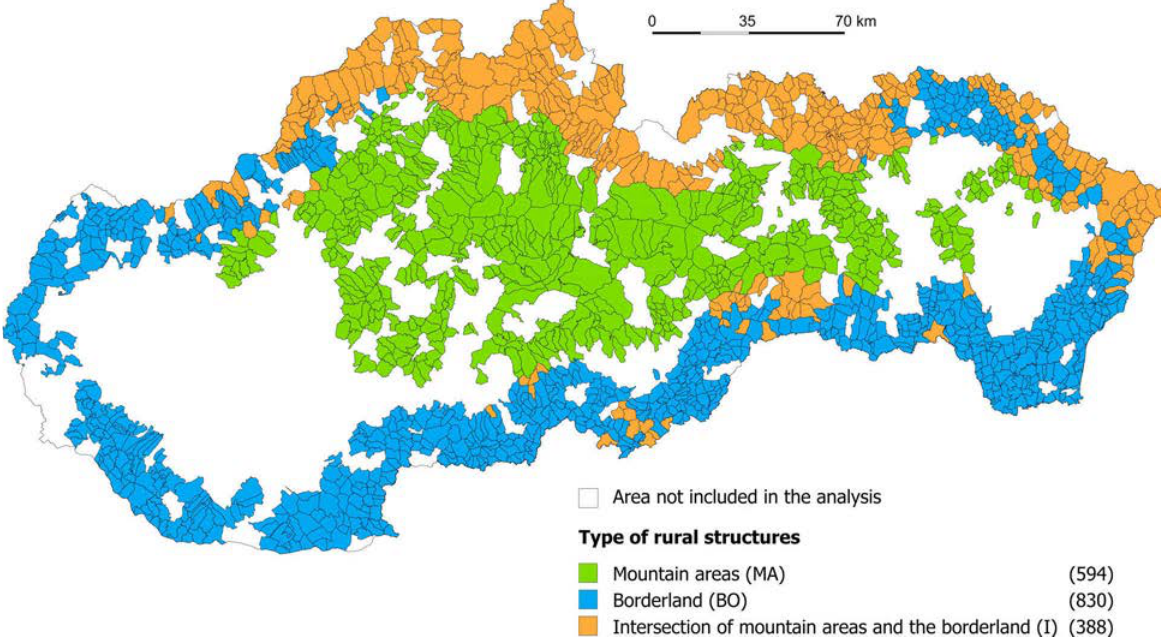
Fig. 1. Rural structures in Slovakia selected for the analysis. Source: authors’